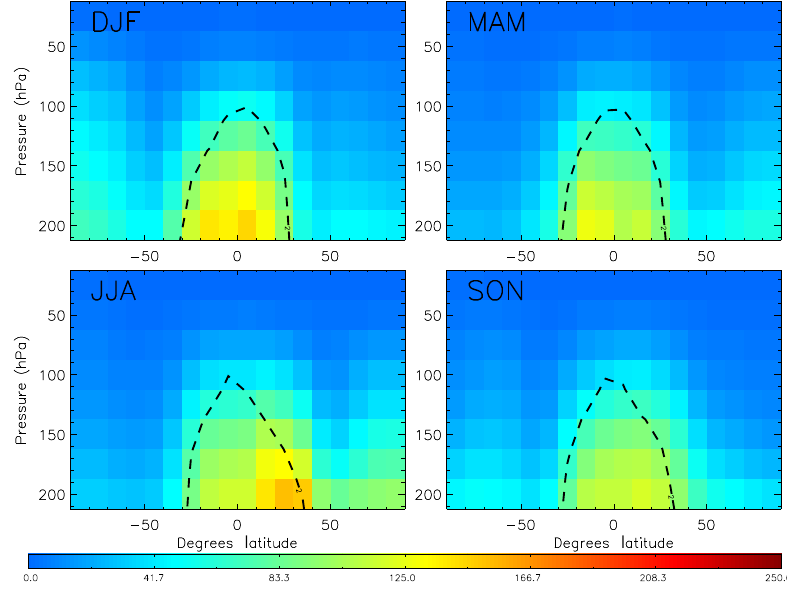
Figure 15. As Fig. 14 but for the application of the UoL averaging kernels to the TOMCAT model